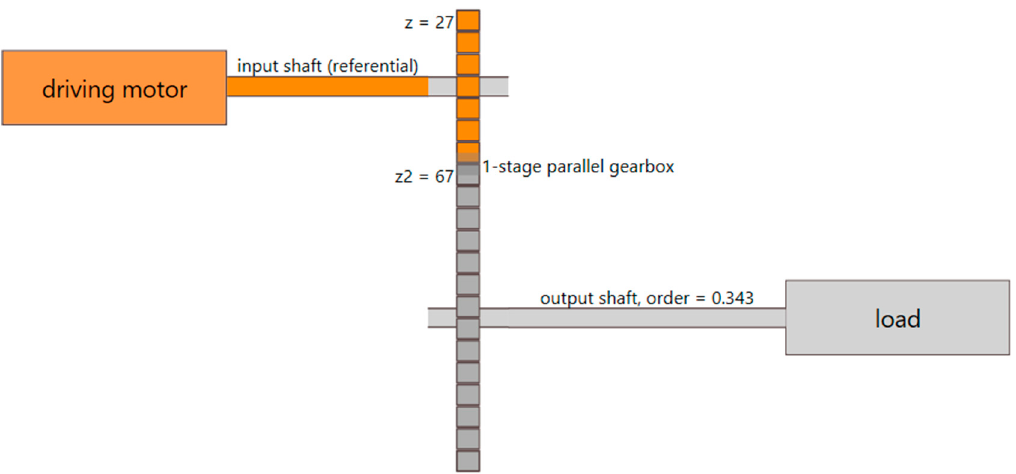
Figure 7. Kinetostatic diagram of the rotating machinery used in the experiment.